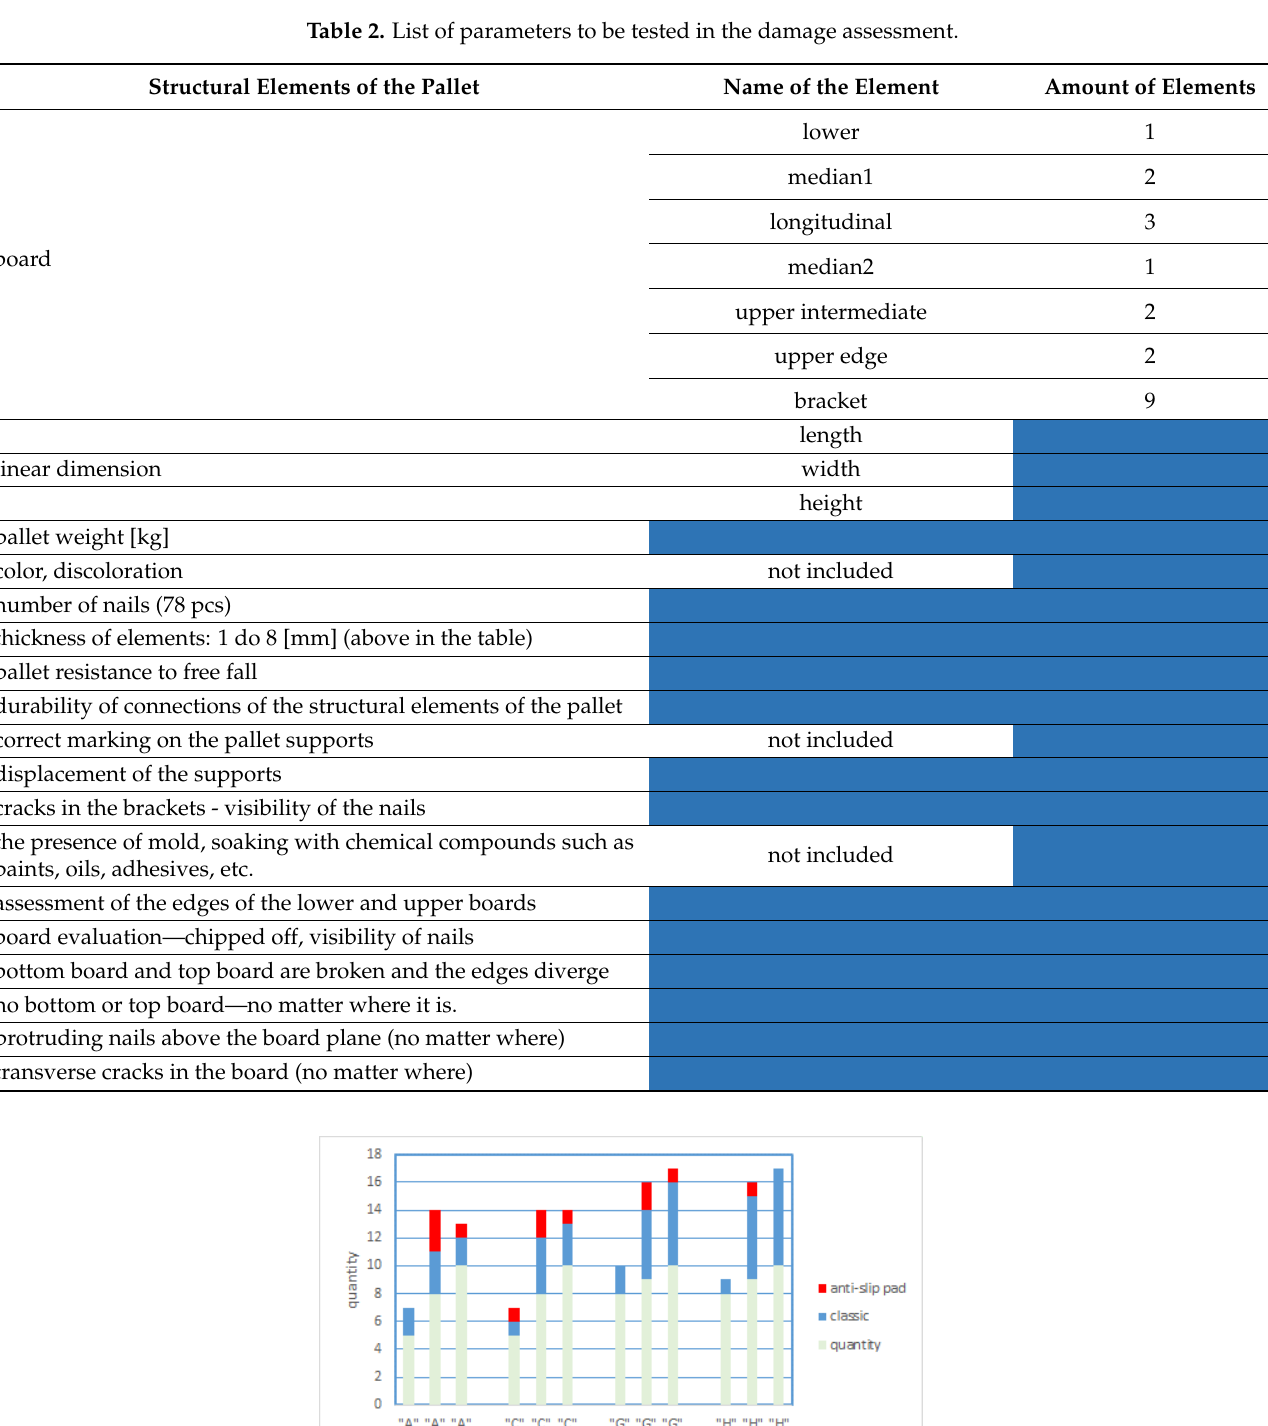
Figure 16. Number of pallets in the group for damage “without” and “with” anti-slip